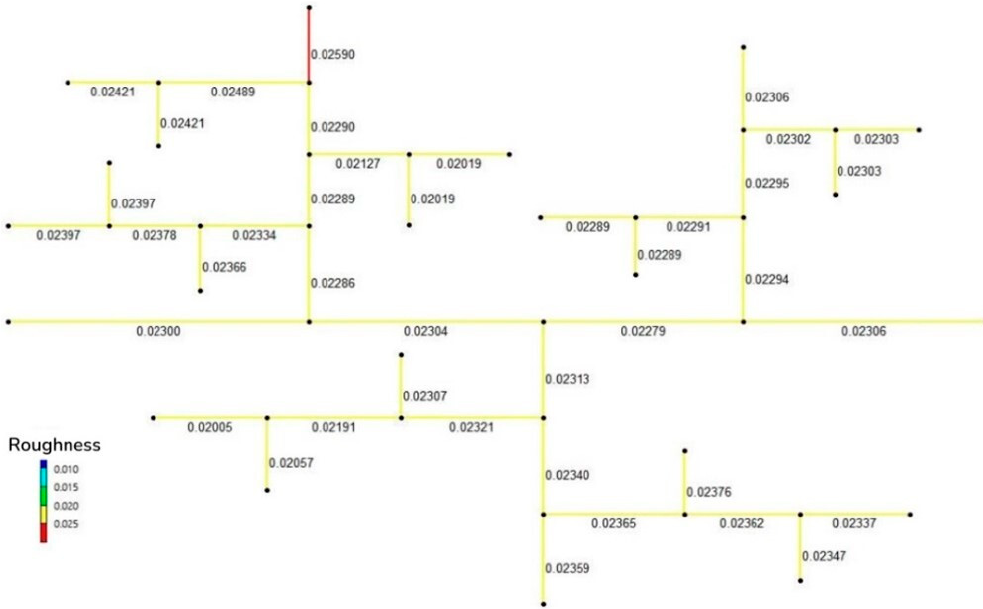
Figure 6. Distribution of inversed values of roughness with three observational stations. Table 2. Roughness RMSE and water-level RMSE at Nodes 3, 7 and 26 with different observational